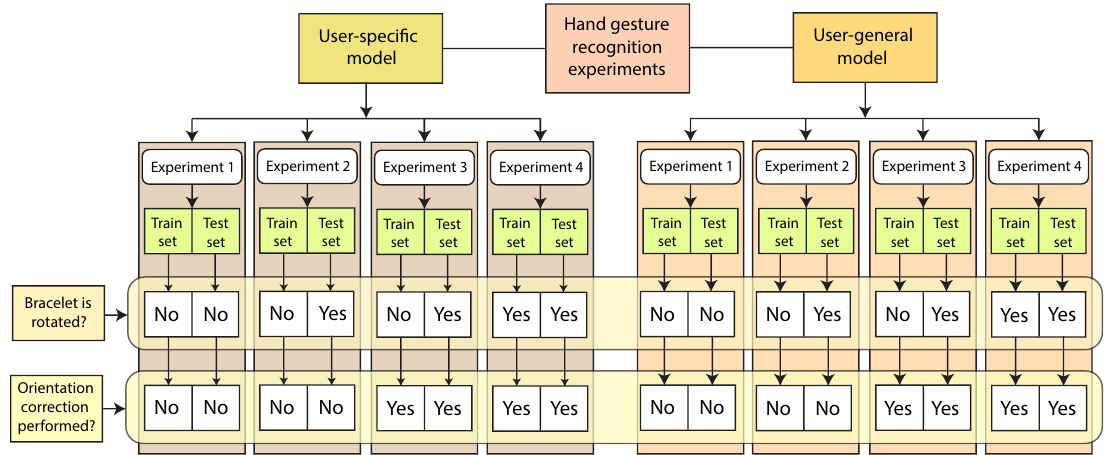
Figure 7. Experiment setup diagram. We performed our experiments using user-specific and user-general models, and for each one of them, we evaluated the bracelet rotation with and without the proposed orientation correction